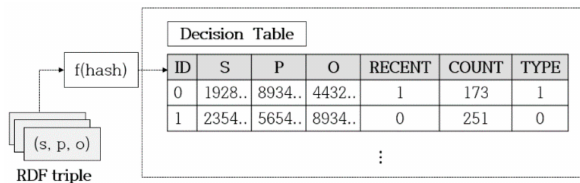
Figure 7. Decision table for training